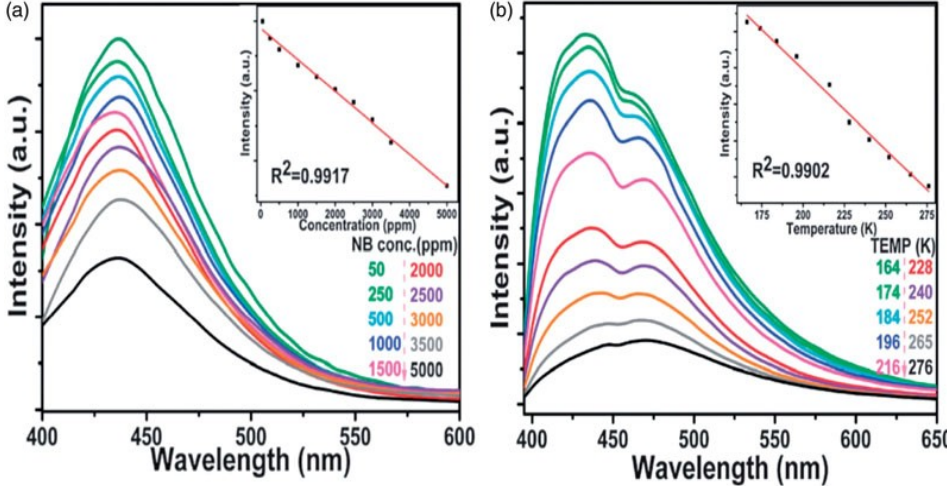
Figure 6. ( a ) Zn–TDPAT emission spectra (kex at lower wavelength) at varied concentration levels and ( b ) various thermal values [131]. Reprinted with the permission of Ref. [126]. Copyright 2013 Royal Society of Chemistry.